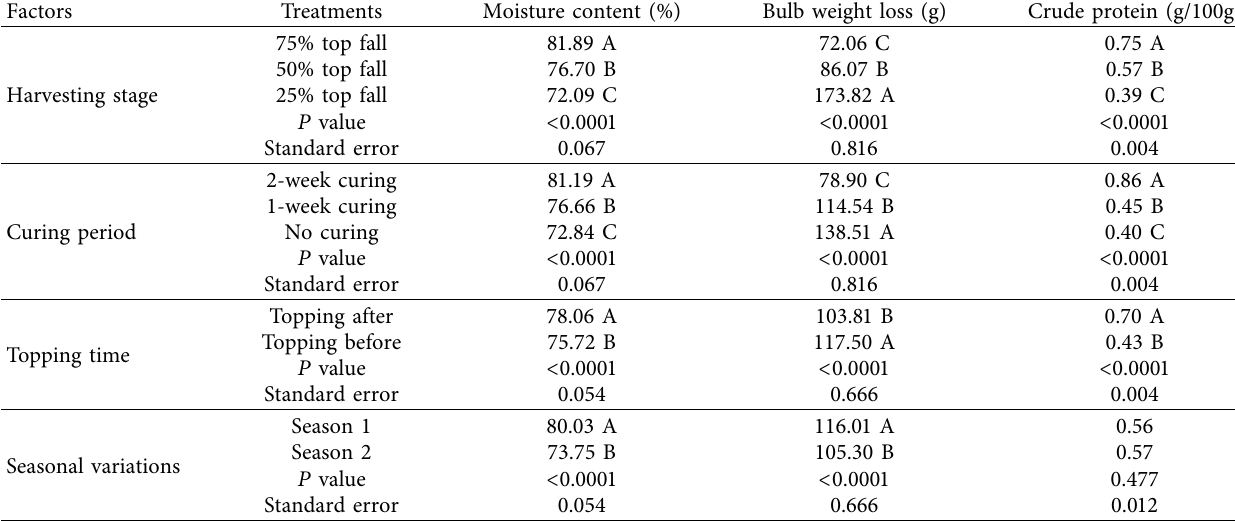
Table 1: Proximate analysis of stored bulb onions as affected by postharvest